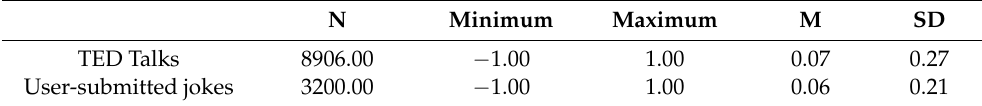
Table 4. Summary of statistics for sentiment analysis.